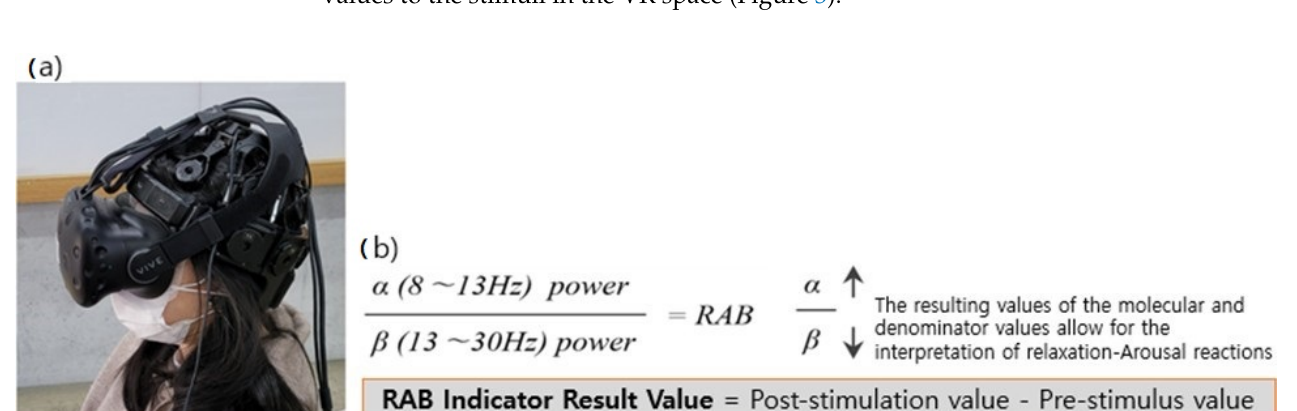
( b ) The ratio of alpha to beta waves (RAB) indicators and formula for deriving results. If the RAB indicator results presented